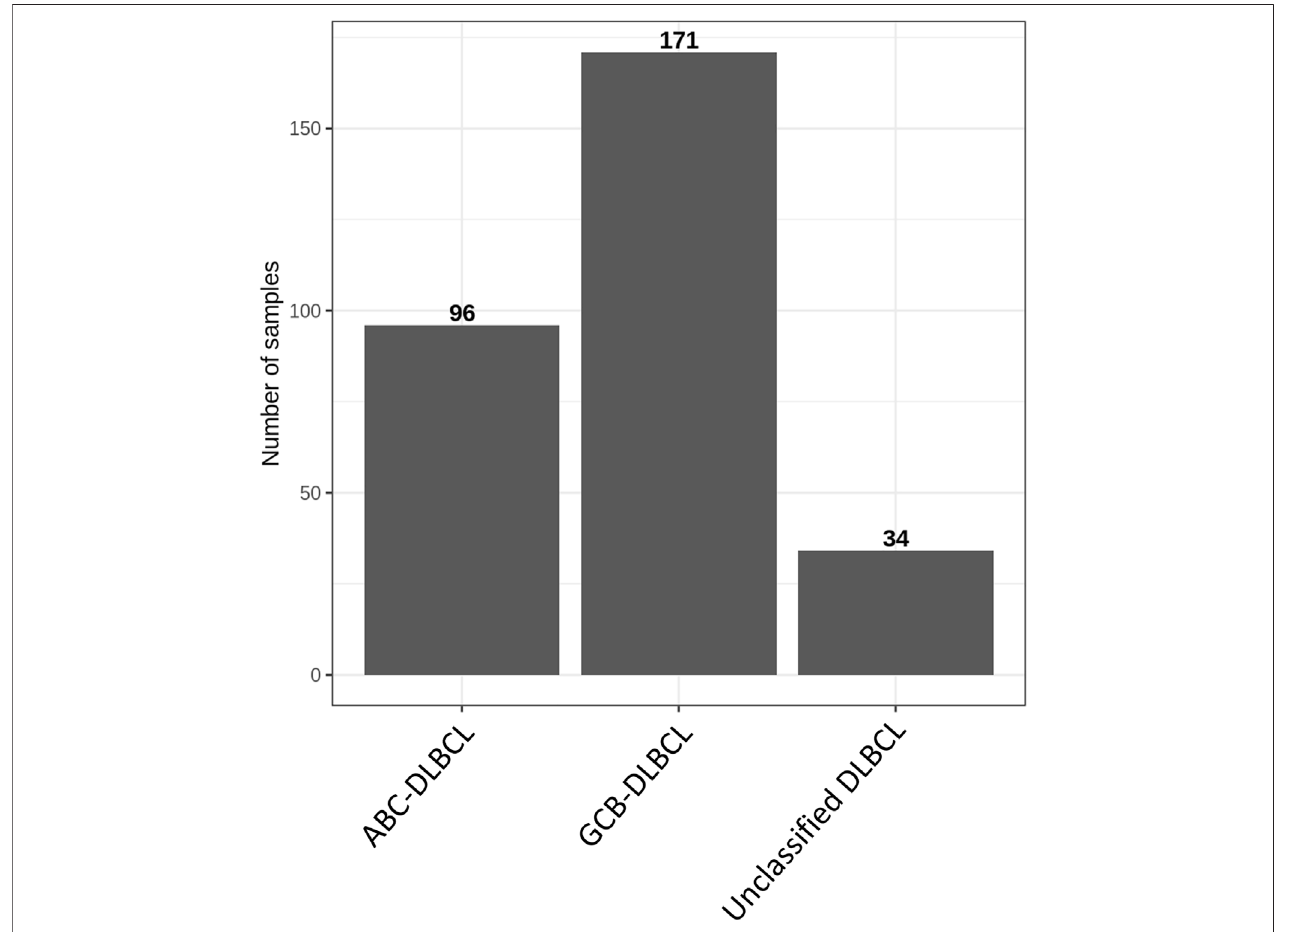
FIGURE3| DLBCLpatientcohortbycelloforiginsubtype.DLBCLpatientsamples(N=301)werecategorizedasABC-DLBCL(N=96),GCB-DLBCL(N=171),or unclassi fi ed DLBCL (N = 34) according to the Lymph2Cx